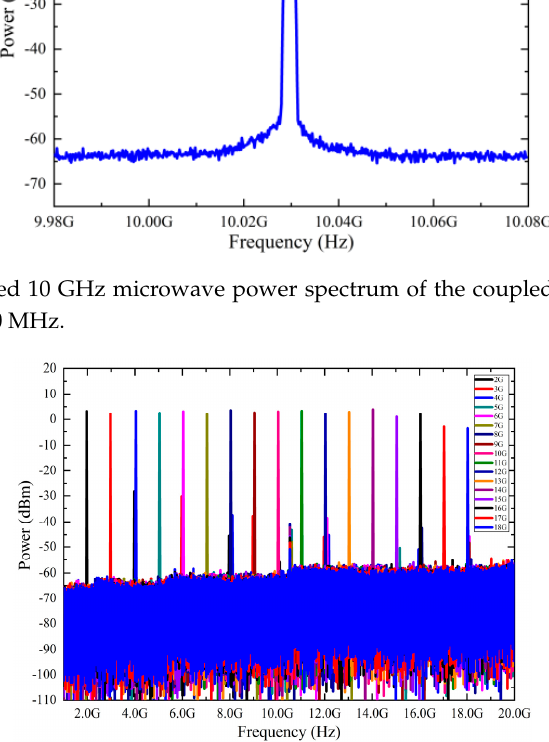
Figure 4. The generated 10 GHz microwave power spectrum of the coupled dual-loop SBS-based TOEO with span of 100 MHz.